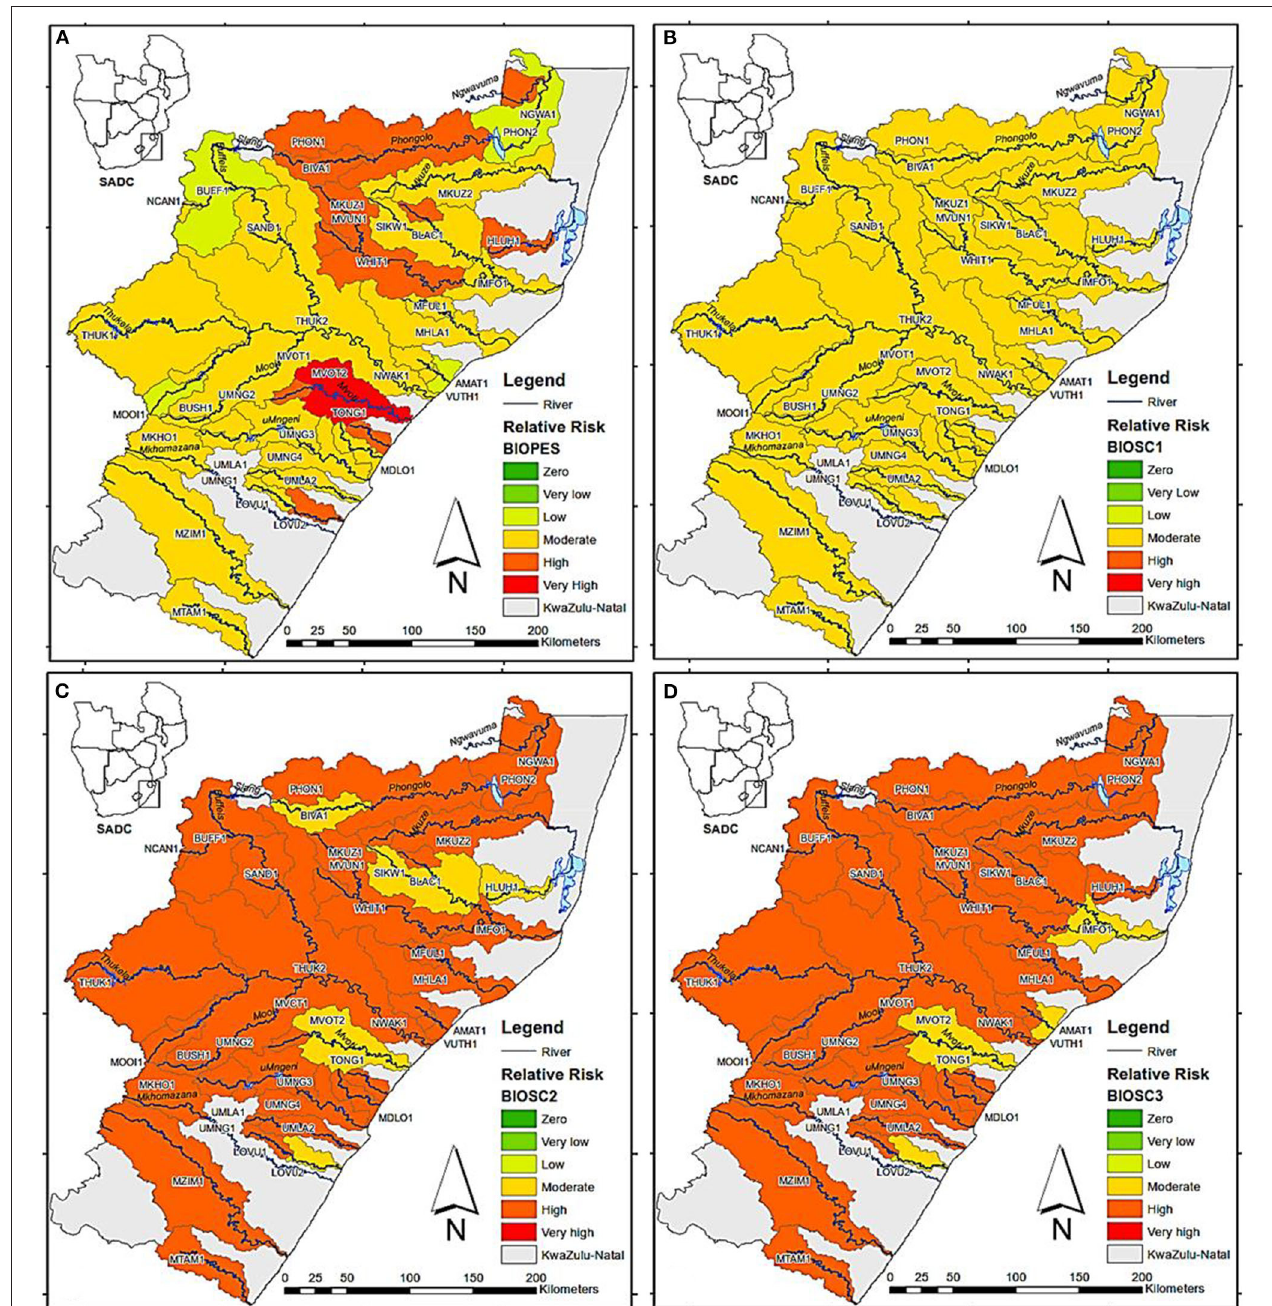
FIGURE 6 | Final biodiversity risk classifications of KwaZulu-Natal rivers studied from 2015 to 2016 based on the present ecological state (A) ; risk associated with low flow (B) ; risk associated with limited or degraded habitat (C) ; and risk associated with poor water quality (D) .